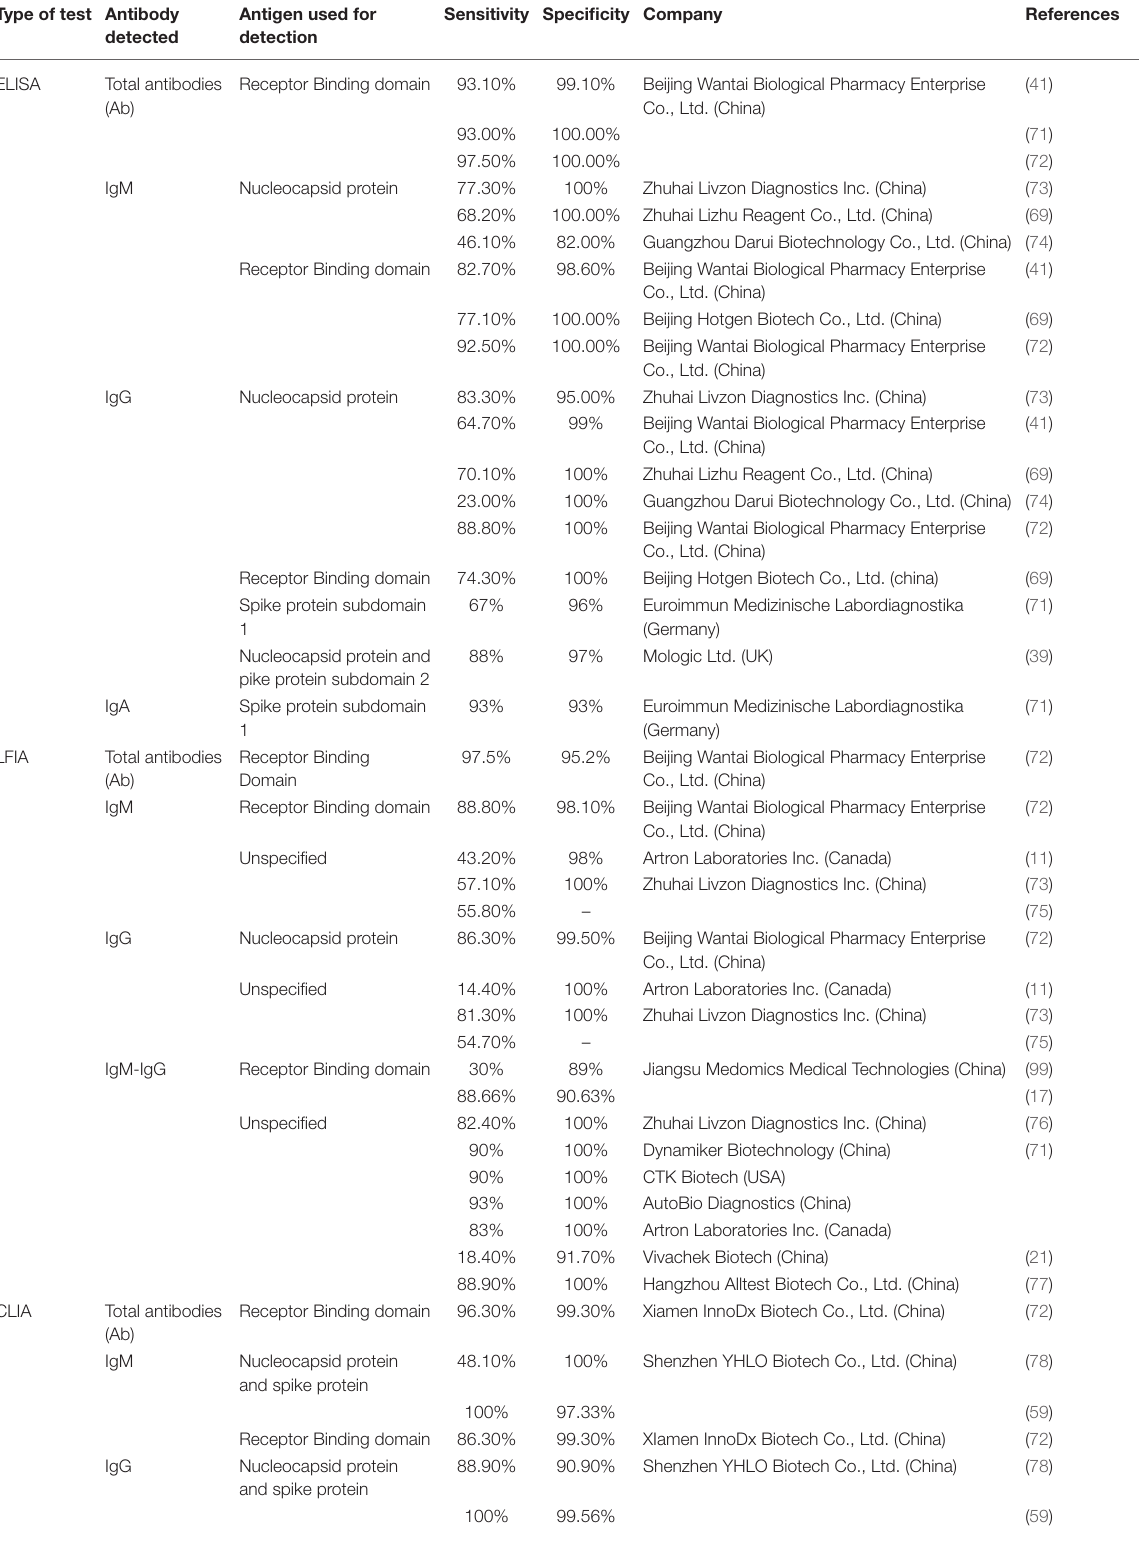
TABLE 3 | Commercial tests performance grouped by antibody detected and antigen used